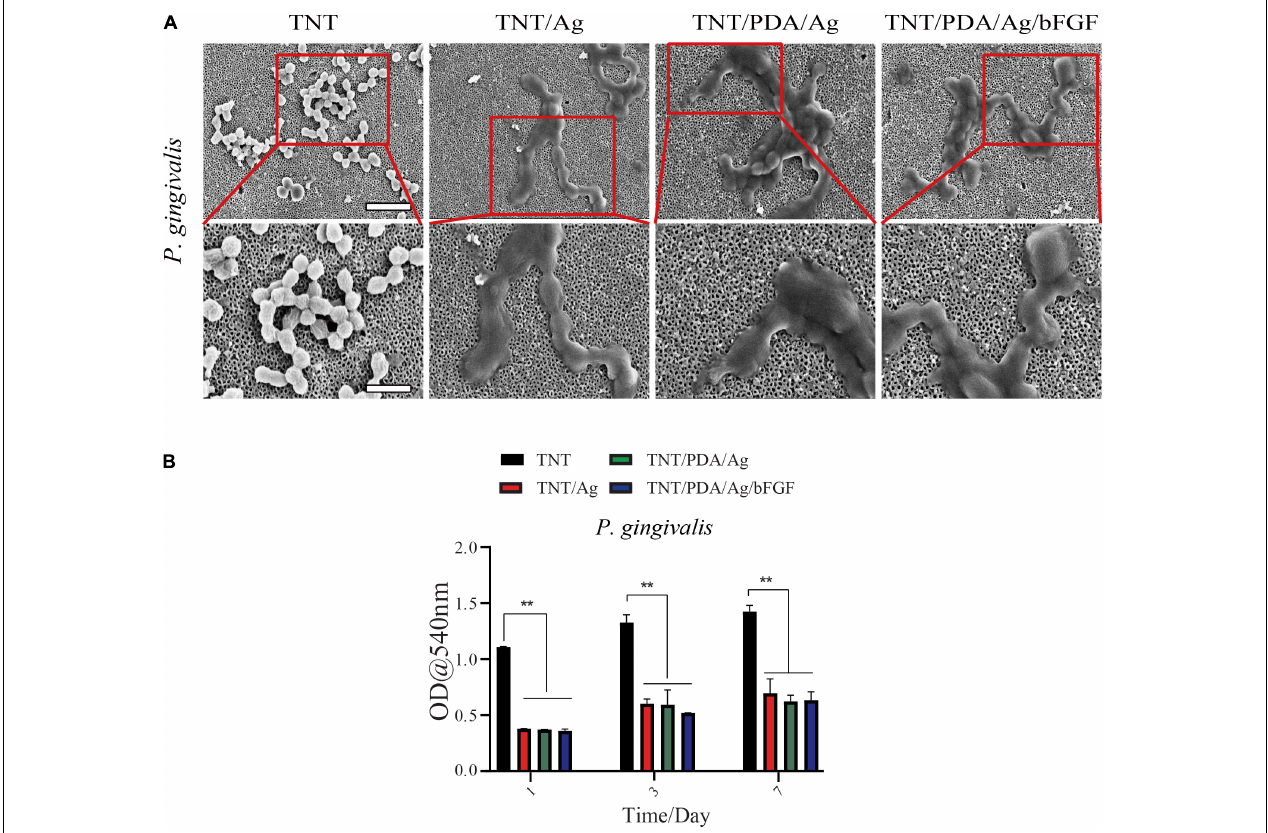
FIGURE 8 | Porphyromonas gingivalis associated with peri-implantitis. (A) SEM images of titanium-modified surfaces after immersion in P. gingivalis culture (scale bar, 5 and 2 µ m). After 24 h of incubation with P. gingivalis , the TNT/Ag, TNT/PDA/Ag, and TNT/PDA/Ag/bFGF were occupied by clusters of P. gingivalis , which formed a visible biofilm. (B) Quantitative analysis of antibacterial ability against P. gingivalis of Ti for 1 and 3 days. Data are presented as mean ± standard deviation; ** p <